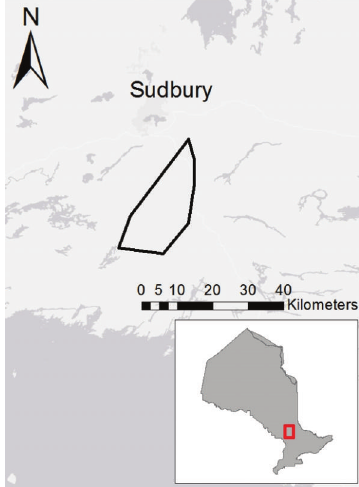
Figure 1: The Burwash elk core population range (polygon) created using females that spent the majority of their time within the main herd in the Burwash area of Ontario.